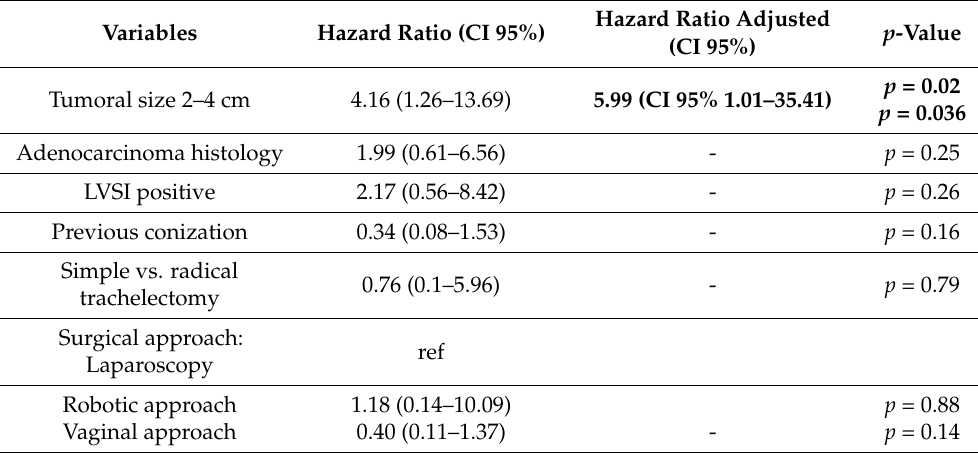
Table 3. Simple Cox regression for predictors. LVSI (Lymph Vascular Space